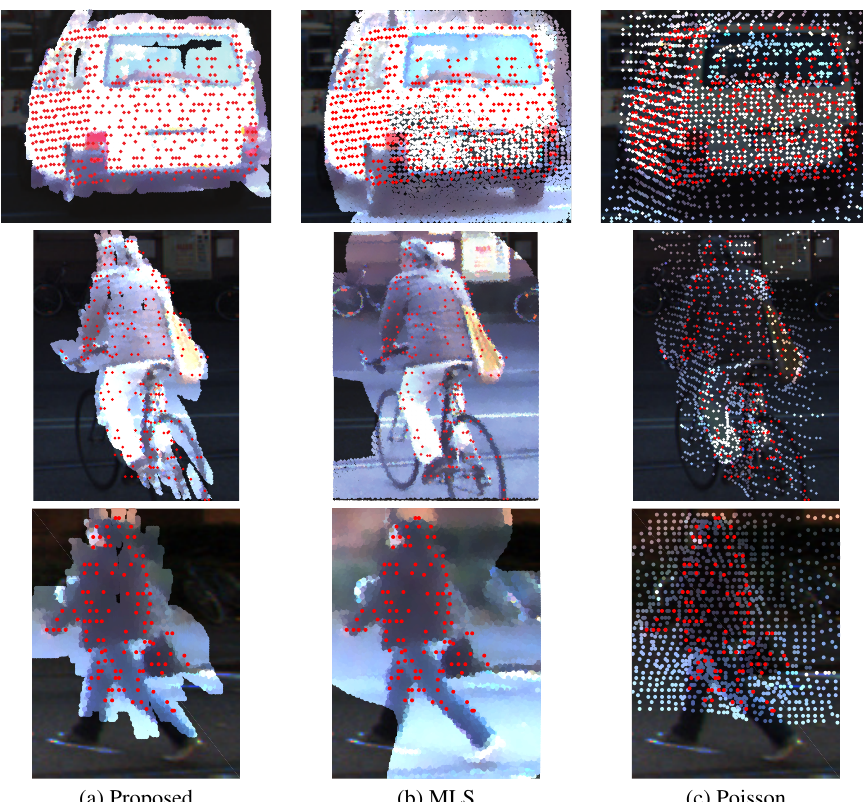
Figure 5: The proposed approach (a) is compared with MLS (b) and Poisson (c) surface reconstruction. The generated surface in our approach does follow boundaries of object in the image. However the MLS and Poisson approaches fail to maintain the boundaries of the